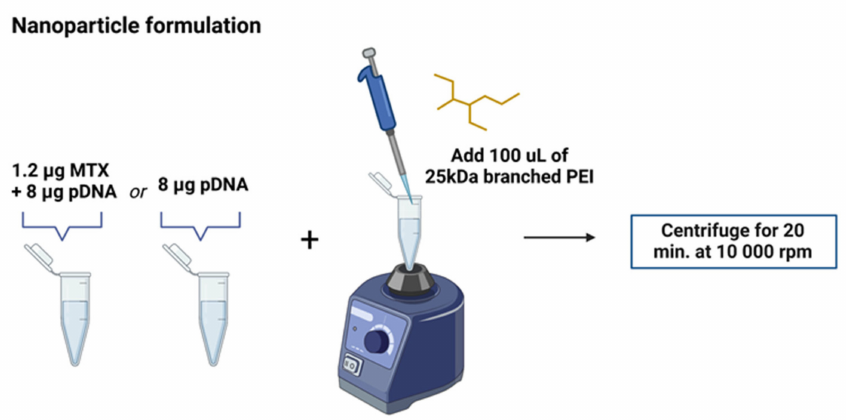
Figure 2. Schematic illustration of the formation of PEI/pDNA or PEI/pDNA/MTX nanoparticles following a co-precipitation method. The detailed description is available in the experimental